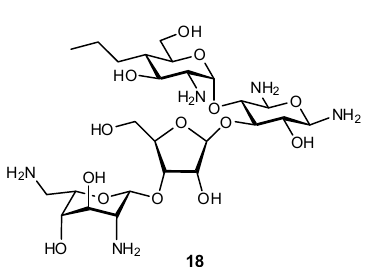
Figure 6. Propylamycin ( 18 ) is a glycomimetic that has shown excellent antibiotic e ffi cacy against several important drug-resistant Gram-negative pathogens. The propyl substituent is believed to enhance nucleophilicity of the endocyclic O atom and thereby enhance the interaction with its electrophilic binding partner [131].